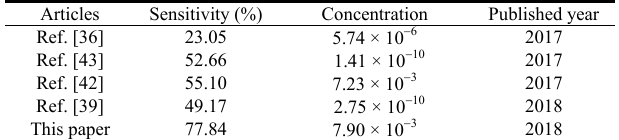
Table 1 Comparison of simulated results in different previous papers for chemical sensing at 1.33  m